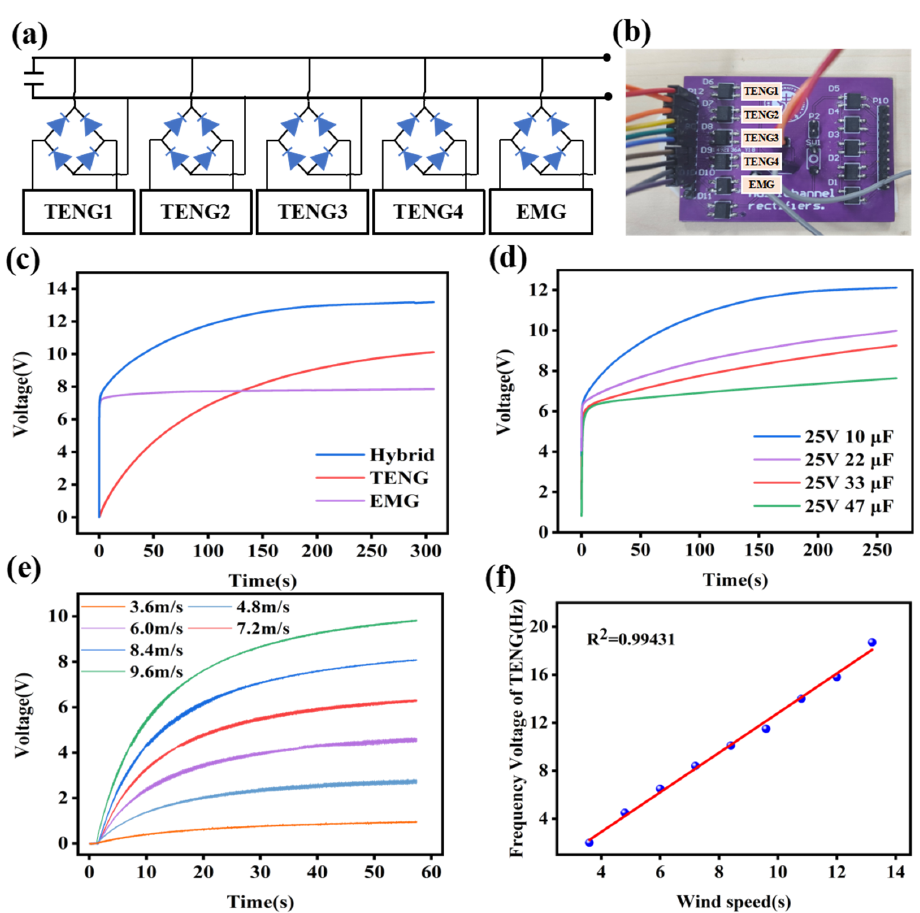
Figure 8. The output performance of ECD: ( a , b ) Rectifier circuit diagram; ( c ) Comparison of charging capacity between TENG and EMG; ( d ) The curves of ECD charging different capacitors; ( e ) The charging curves of ECD at different speeds; ( f ) Linear relationship between voltage frequency and wind